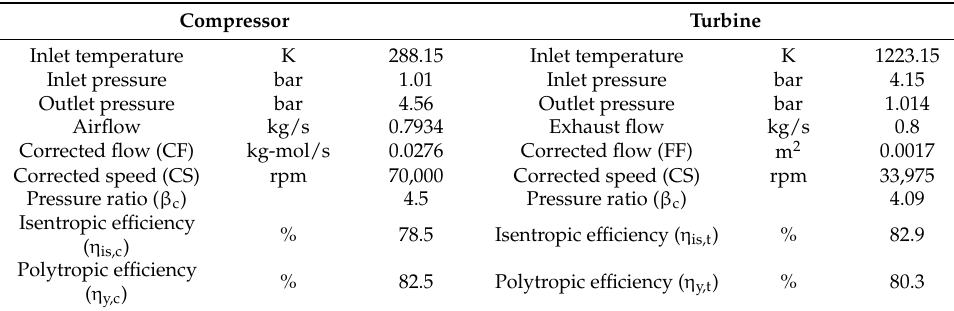
Table 2 summarizes design point features for both the compressor and turbine. Table 2. Design features of the compressor and